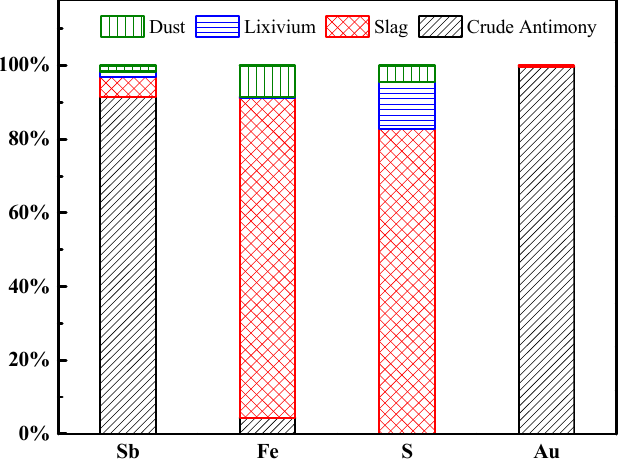
Figure 10. The distribution behaviors of main elements in products during confirmation experiments. Table 3. Chemical compositions of resultants in confirmation